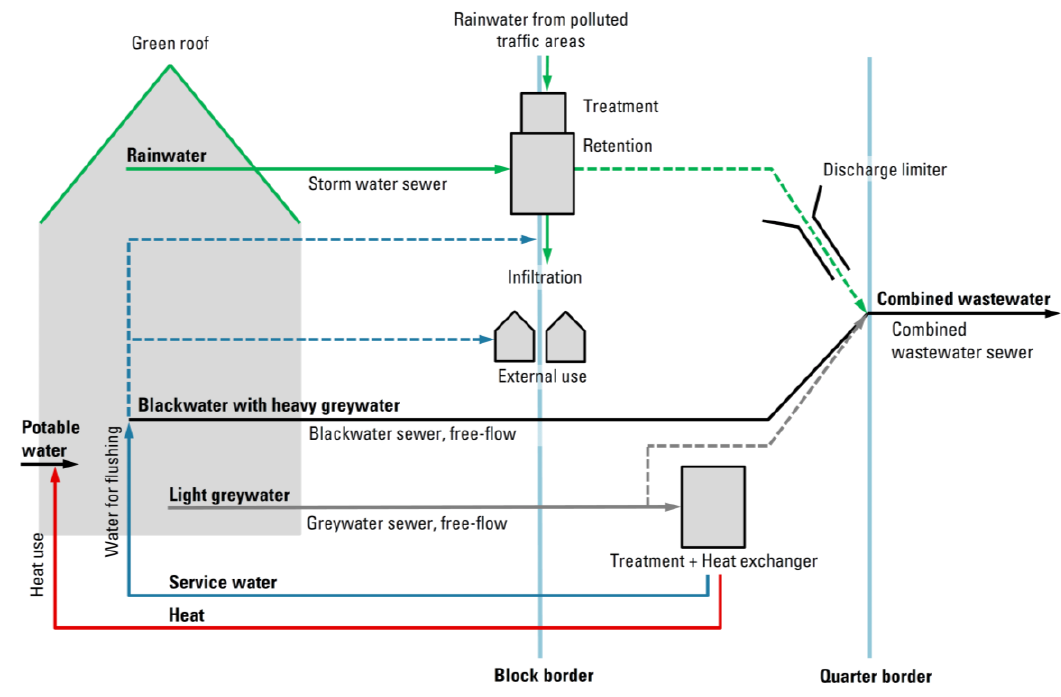
Figure 1. Scheme of the ConvGrey Frankfurt technical option at the quarter level (based on [31]). ConvGrey Hamburg: In this technical option, greywater (light and heavy greywater, i.e.,